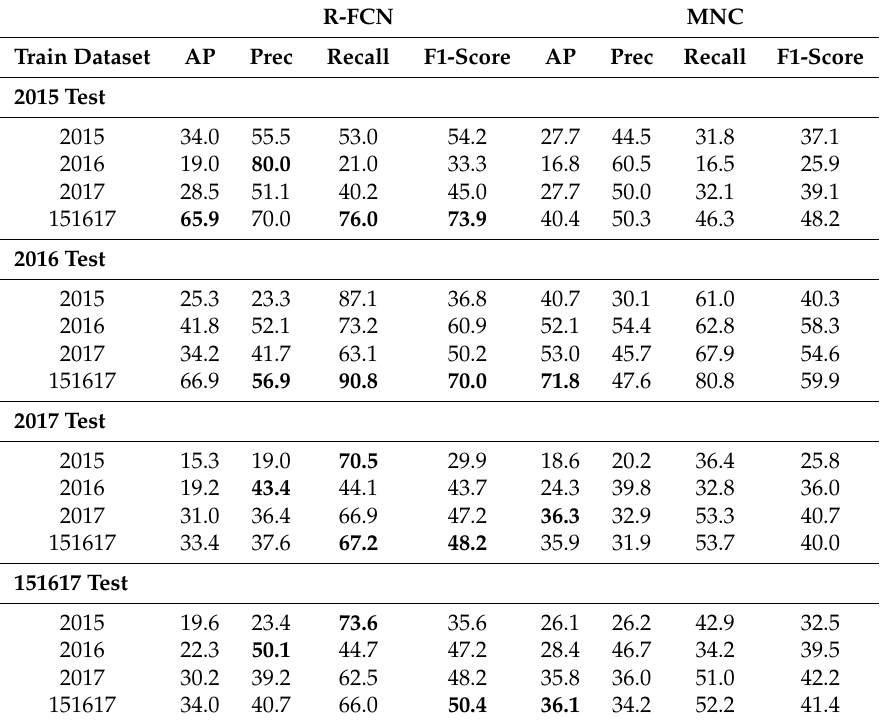
Table 3. Computer vision metric results for both the R-FCN and MNC models across the four test sets. R-FCN MNC Train Dataset AP Prec Recall F1-Score AP Prec Recall F1-Score 2015